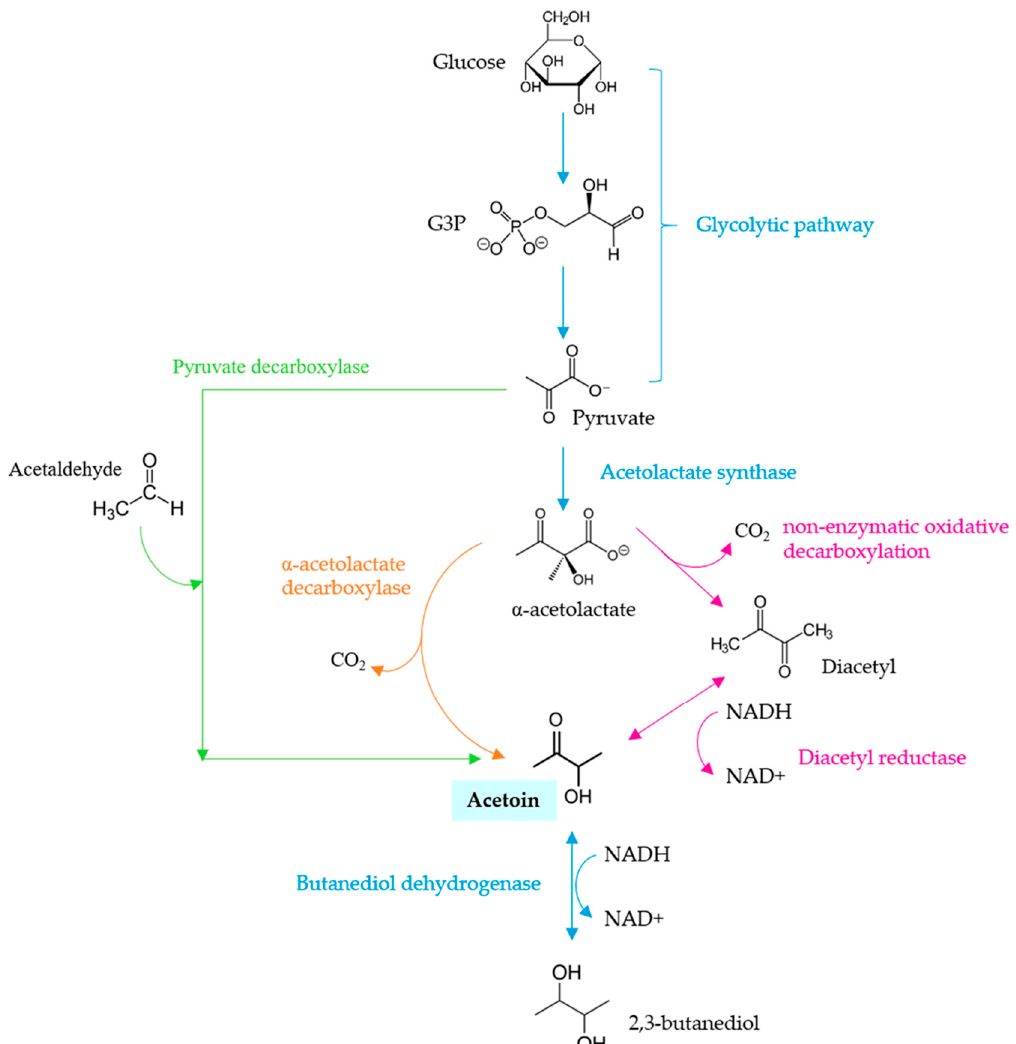
Figure 3. Metabolic route for the biosynthesis of acetoin by yeasts (adapted from Romano and Suzzi,